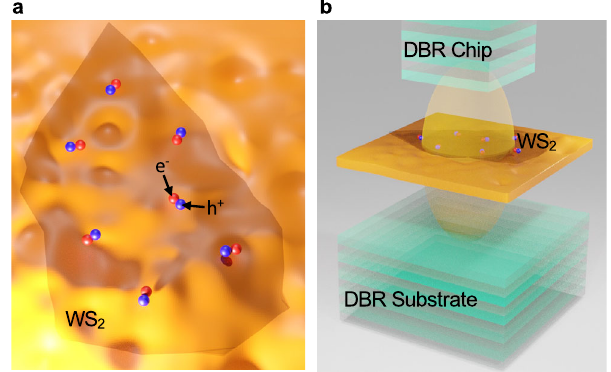
Fig. 1 Excitons and polaritons in a disordered environment. a Schematic picture of monolayer WS 2 hosting bound electron-hole pairs (excitons) placed on a substrate with substantial dielectric disorder with the spatial scale comparable with the exciton size 32 . The electrons and holes are represented by red (e − ) and blue (h + ) balls, respectively. b Hybridisation of excitons and photons, leading to formation of polaritons in an all-dielectric high-Q optical microcavity, reduces the effect of dielectric disorder 33